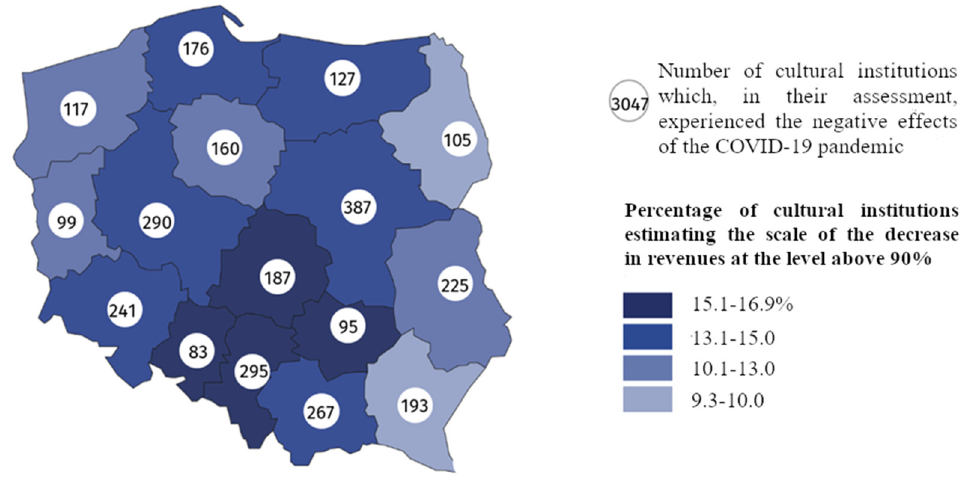
Figure 4. Cultural institutions which in their assessment experienced the negative effects of the COVID-19 pandemic in the second quarter of 2020. Source: (Statistics Poland 2020b).